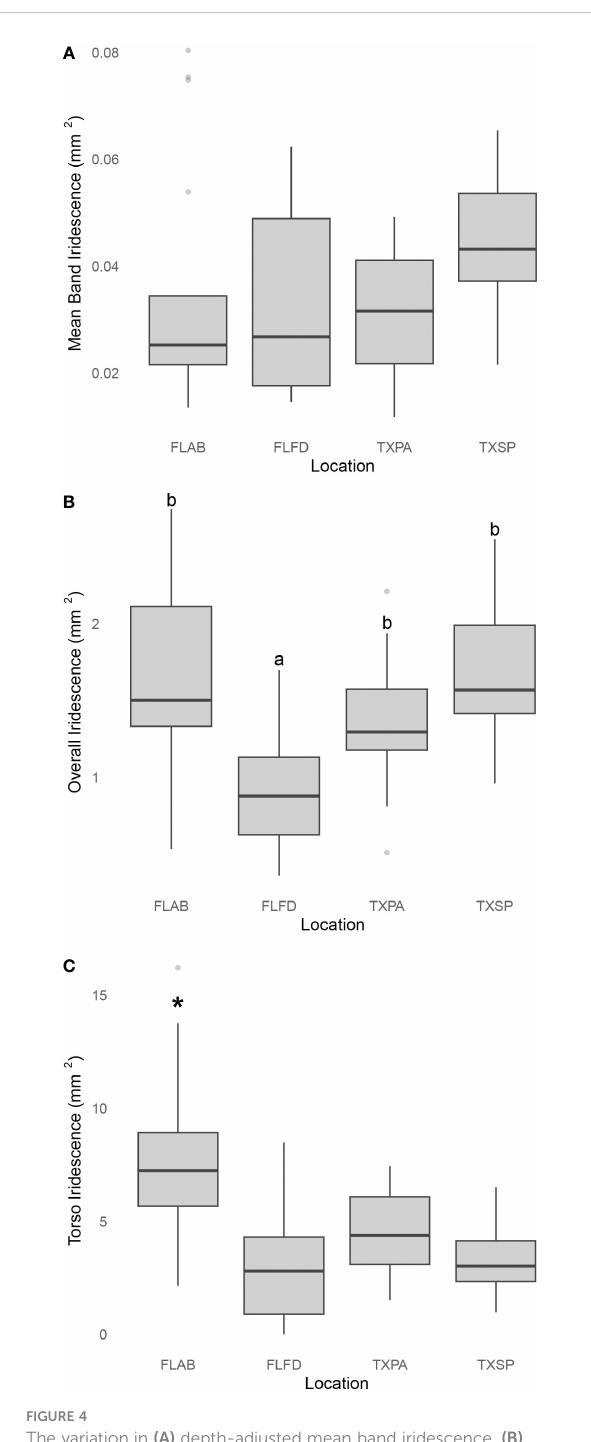
FIGURE 4 The variation in (A) depth-adjusted mean band iridescence, (B) depth-adjusted overall iridescence, and (C) torso iridescence across four distinct populations of female S. scovelli . These populations include two from Florida [Anne ’ s Beach (FLAB) and Fort DeSoto (FLFD)] and two from the coast of Texas [Port Aransas (TXPA) and South Padre (TXSP)]. Mean band iridescence was not signi fi cant across the geographic locations and both overall iridescence and torso iridescence differed signi fi cantly between the different populations. Letters denote results from Tukey HSD post-hoc analysis; different letters represent signi fi cantly different populations (P<0.05). The asterisk above FLAB in (C) denotes the overwhelmingly positive estimates from the GLMM compared to the substantially negative estimates corresponding to the other three